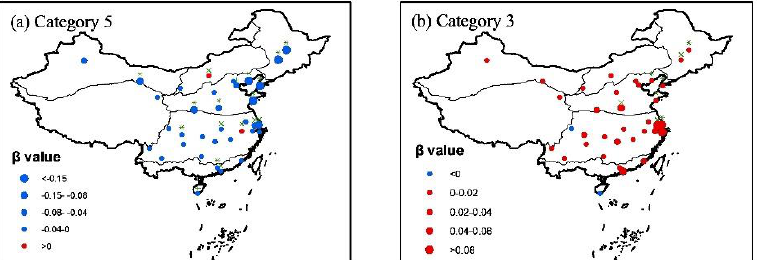
Figure 8. Trend analysis of the changes in day number under no thermal tress ( a ) and strong heat stress ( b ) in summer from 1961 to 2020.